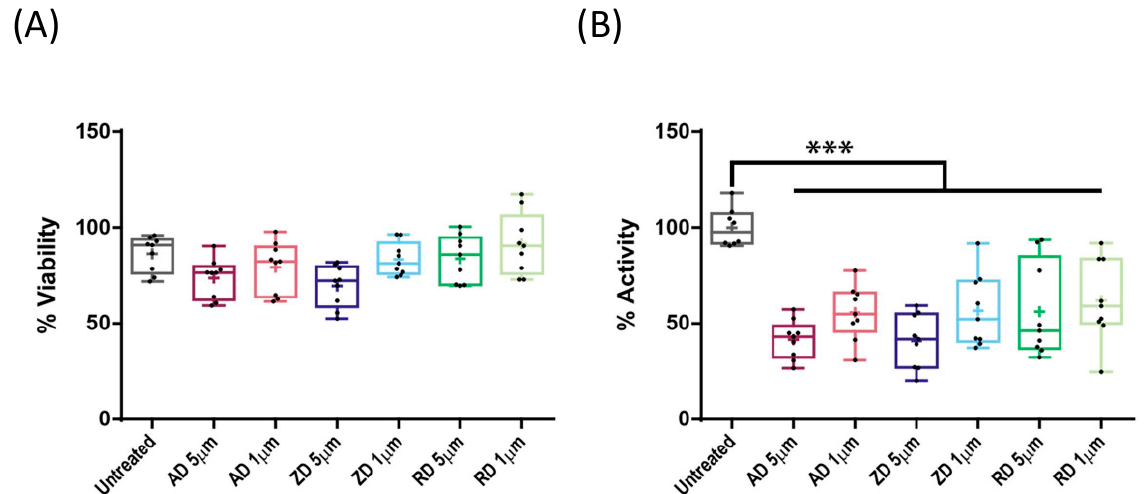
Figure 3. ( A ) Effects of alendronate (AD), zoledronate (ZA), and risedronate (RD) at the indicated concentrations on cell viability. ( B ) Effects of AD, ZD, and RD treatments, at the indicated concentrations, on wild-type CYP1A1 enzymatic activity (*** p < 0.001). Activities are expressed as percentages of the untreated wild type. All experiments were performed thrice including three replicas each and p values < 0.05 were considered significant.